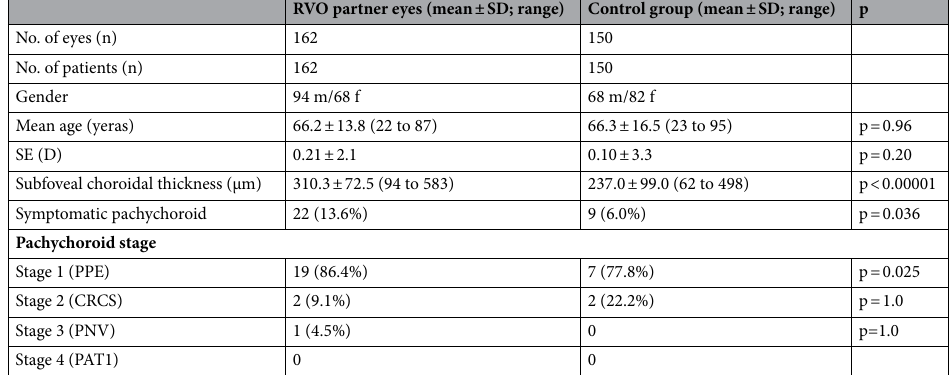
RVO partner eyes (mean ± SD; range) Control group (mean ± SD; range)